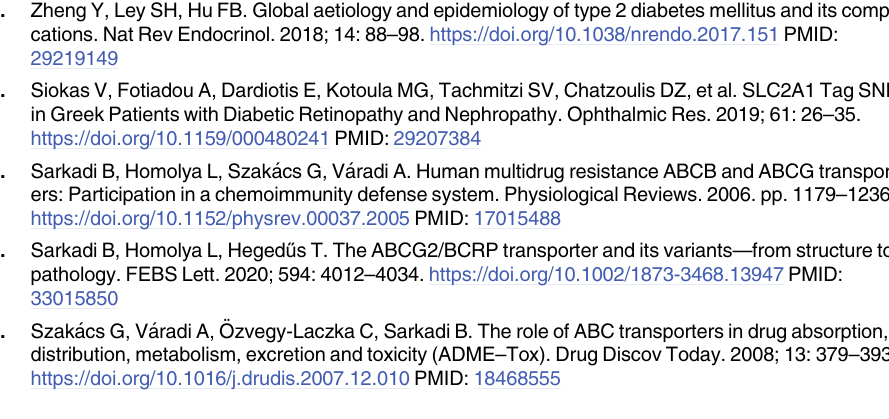
S1 Table. The details of the PheWAS associations of ABCG2-Q141K for uric acid, HbA1c and fasting glucose traits (from https://t2d.hugeamp.org). A , Summary of the PheWAS data. B , Key data from the databases used in the meta-analysis. The p values were calculated by bottom-line meta-analysis across all datasets in the Type 2 Diabetes Knowledge Portal. The Beta coefficient is the estimated difference in a phenotype between a heterozygous carrier of the effect allele and a homozygous reference allele carrier. Green arrow: positive correlation between the effect allele and the phenotype, red arrow: negative correlation. S2 Table. The datasets analyzed during the current